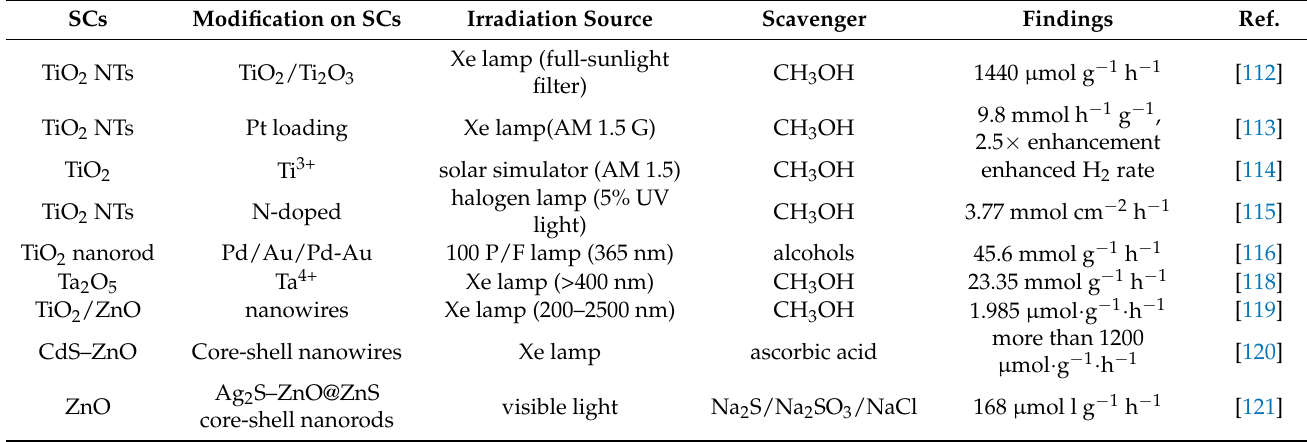
Table 2. Examples of 1D photocatalysts for photocatalytic hydrogen evolution.